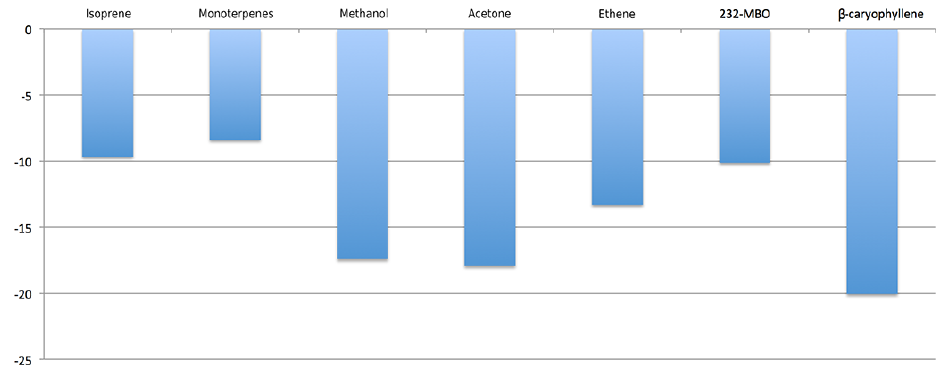
Figure 8. Global relative emission differences (%) between the sensitivity simulations PFT-JSBACH and PFT-CLM4 for isoprene, monoter- penes, methanol, acetone, ethene, 232-MBO, and β -caryophyllene.